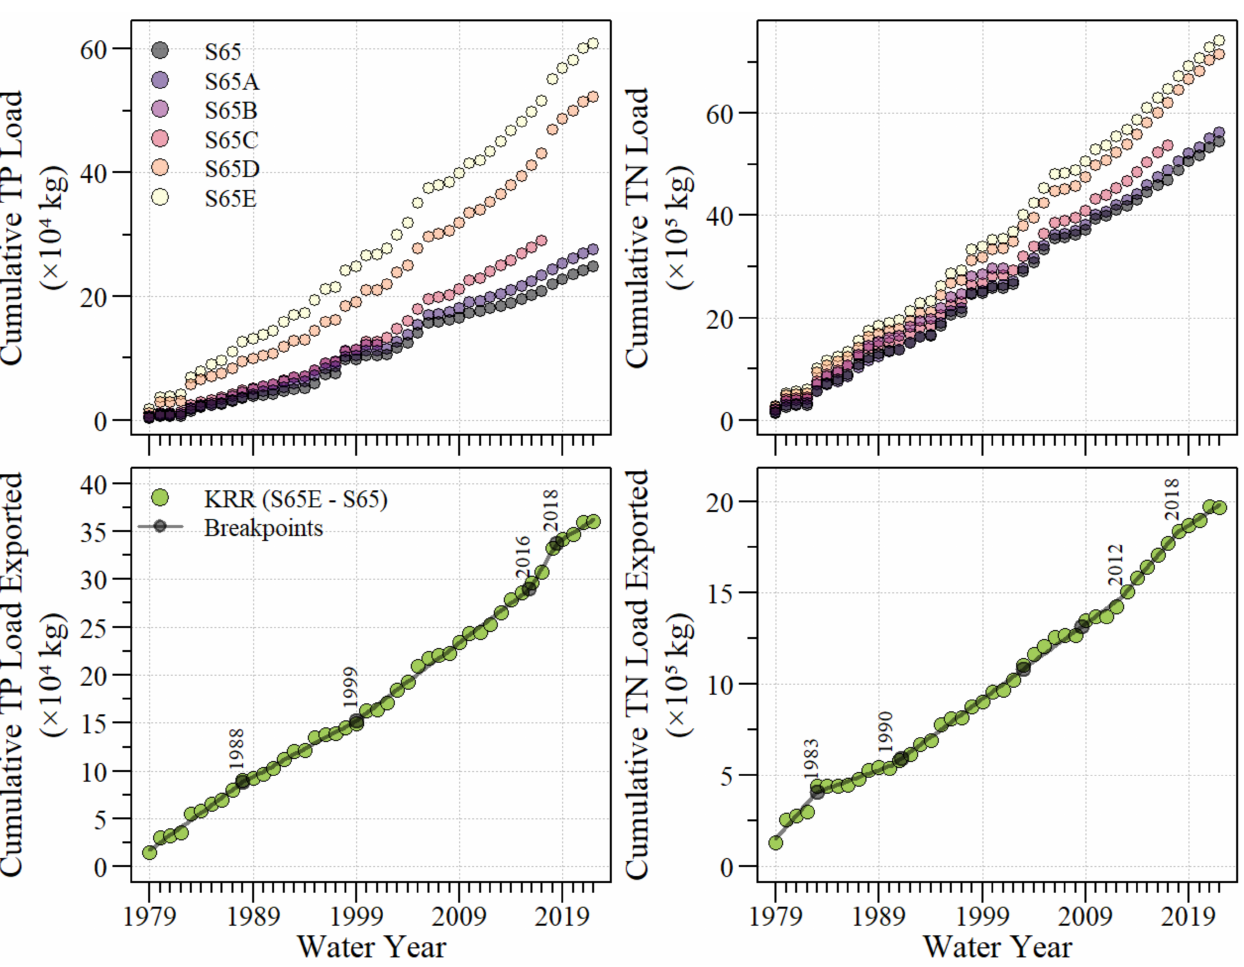
Figure 4. Top: cumulative annual load for each water control structure within the Kissimmee River floodplain for total phosphorus (TP, left ) and total nitrogen (TN, right ). Bottom: cumulative annual TP and TN load exported from the Kissimmee River during the water year 1979 to 2022 period of